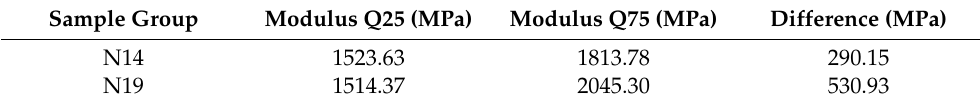
Figure 16. Local elastic modulus calculated between 10 MPa and 5 MPa. While the downward spikes are almost at the same level, the N19 curves spike upwards significantly higher than the N14 curves. Matching the number of extrusion lines in the observed region, the red lines of N19 peak five times, while the blue lines of N14 have more but smaller peaks. The 25% and 75% quantiles of the parameter sets confirm that the lower range is almost identical, while the upper differs significantly, with N19 having almost double the difference between them compared to N14 as listed in Table 3. Table 3. 25% and 75% quantiles and difference of local modulus curves of N14 and N19. Sample